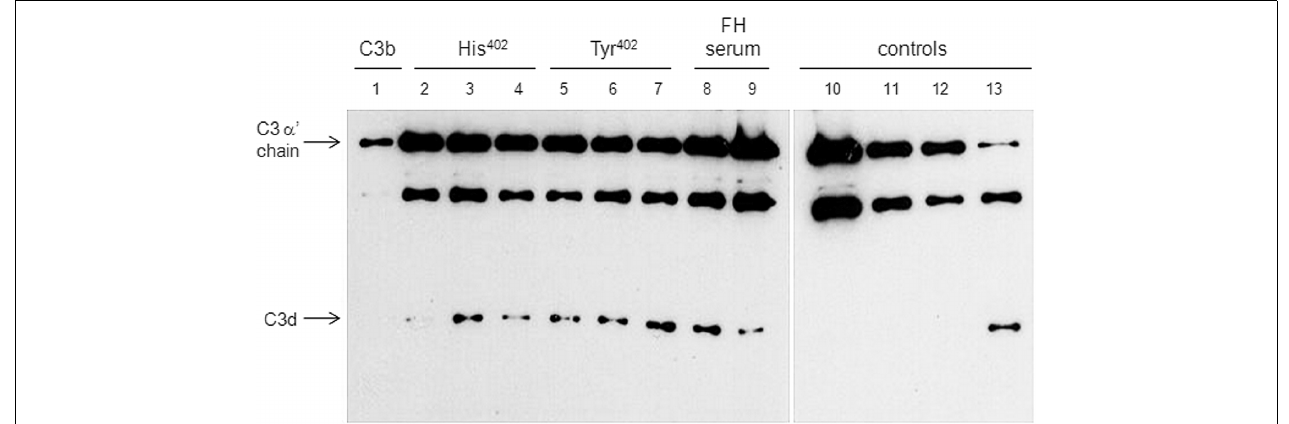
bacteria. C3b alone (1) or C3b mixed with 0.5 μ g of FH (2 and 5); 2.5 μ g of FH (3 and 6); 10 μ g of FH (4 and 7); 100 μ l of serum from FH His 420 subject (8); 100 μ l of serum from FHTyr 420 subject (9). Lanes 10–13: reactions without Leptospira . Only C3b (10); C3b + FH (11); C3b + FI (12); C3b + FH + Factor I (13). Both variants of FH were purified only by affinity